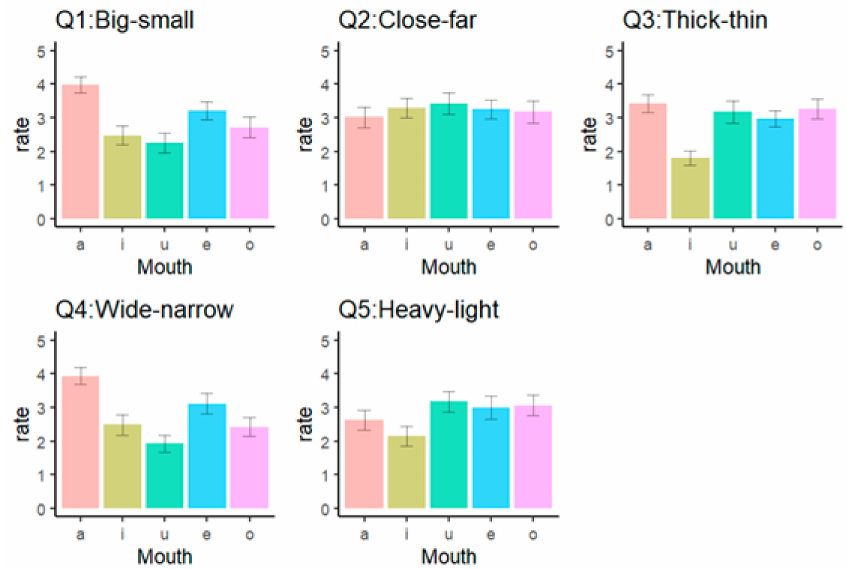
Figure 2. Results of the analysis of Q1 (size), Q2 (distance), Q3 (thickness), Q4 (extent), and Q5